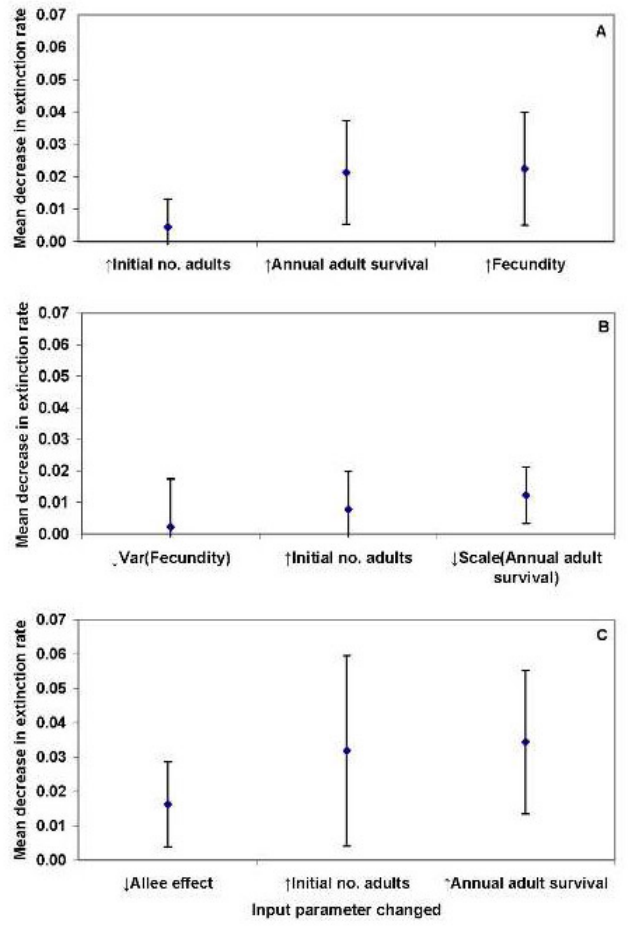
Fig. 6. Small, proportional changes in input parameters expected to decrease probability of extinction in a stage-based, discrete, stochastic population model for large-bodied woodpeckers. Each graph represents the set of mean changes from an analysis that focused on variation in particular drivers of population dynamics: (A) Variation in demographic rates: variances of annual adult survival and fecundity were held constant at intermediate values while either initial number of adults increased by 1, annual adult survival increased by 0.008, or fecundity increased by 0.039; (B) Environmental stochasticity: means for annual adult survival and fecundity were held constant at intermediate values while either lognormal variance in fecundity decreased by 0.0089, initial number of adults increased by 1, or the scaling parameter for the logitnormal variance in annual adult survival decreased by 0.0442, and (C) Allee effect: variance in annual adult survival and mean and variance in fecundity were held constant at intermediate values while either the slope of the relationship between annual population size and probability of breeding increased by 0.14, initial number of adults increased by 1, or annual adult survival increased by 0.008. Results displayed in each graph are based on 200 iterations across all possible combinations of input parameters. Whiskers represent 95% confidence intervals. The largest decreases in predicted extinction rate occurred when an Allee effect was present and an initial adult was added or annual adult survival rate was increased by a small, proportional